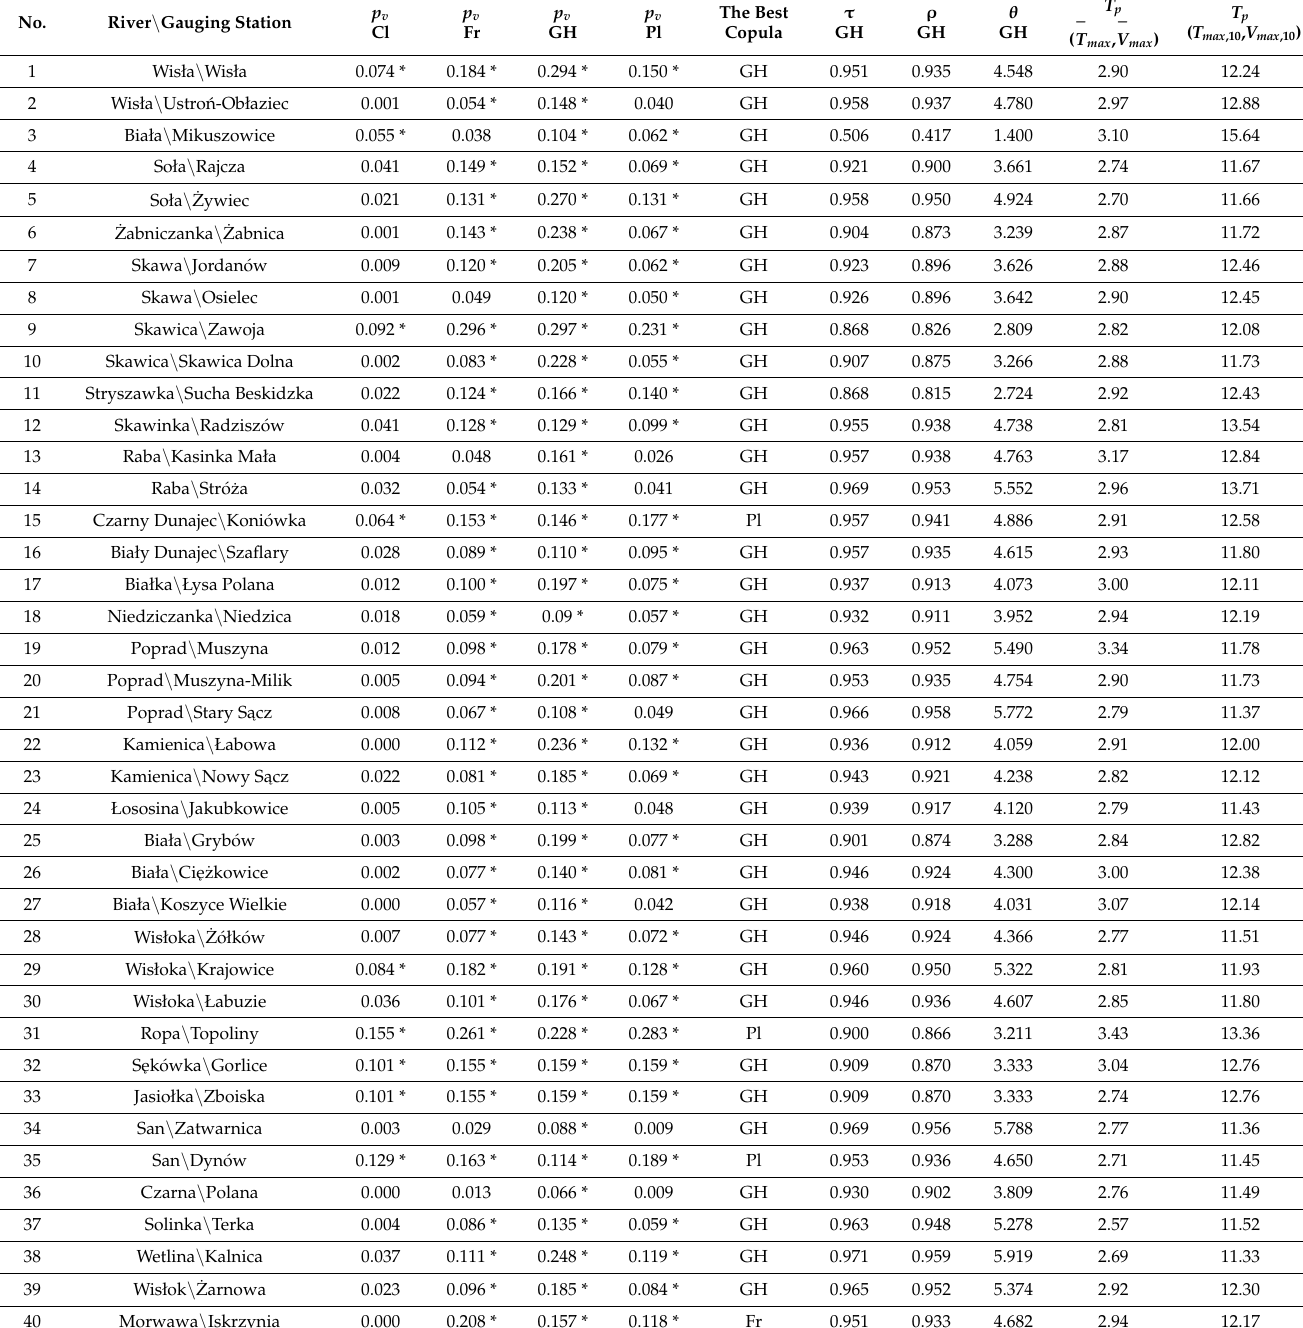
(cid:0) (cid:1) T max , V max